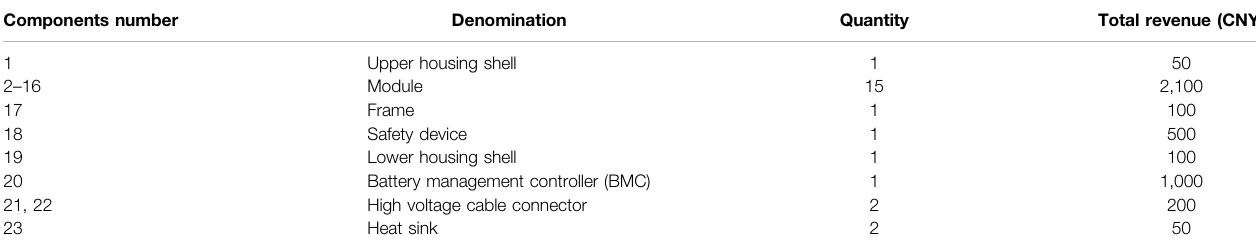
TABLE 2 | Recycling revenue of each component in the